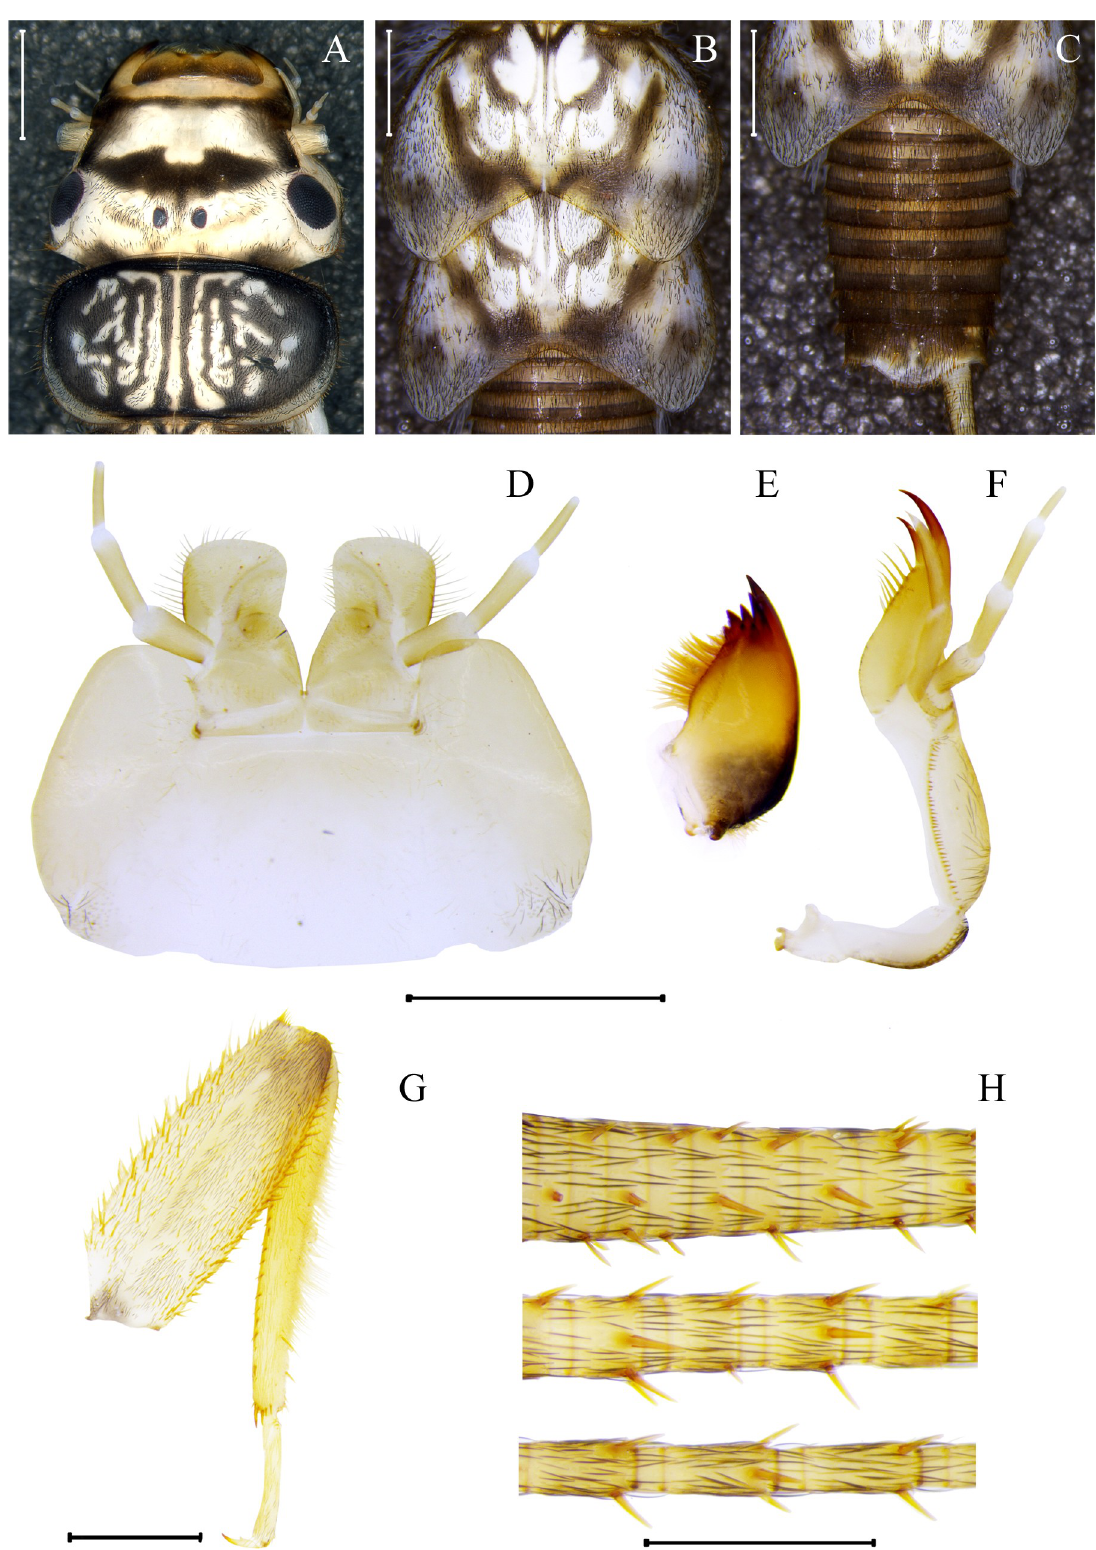
Fig 9. Anacroneuria tupi nymph. Head and pronotum (A), mesonotum and metanotum (B), abdomen (C), labium (D), right mandible (E), right maxilla (F), foreleg (G), cercus in proximal, medial and distal views (H). Scales: 1 mm for A–G and 0.5 mm for H.